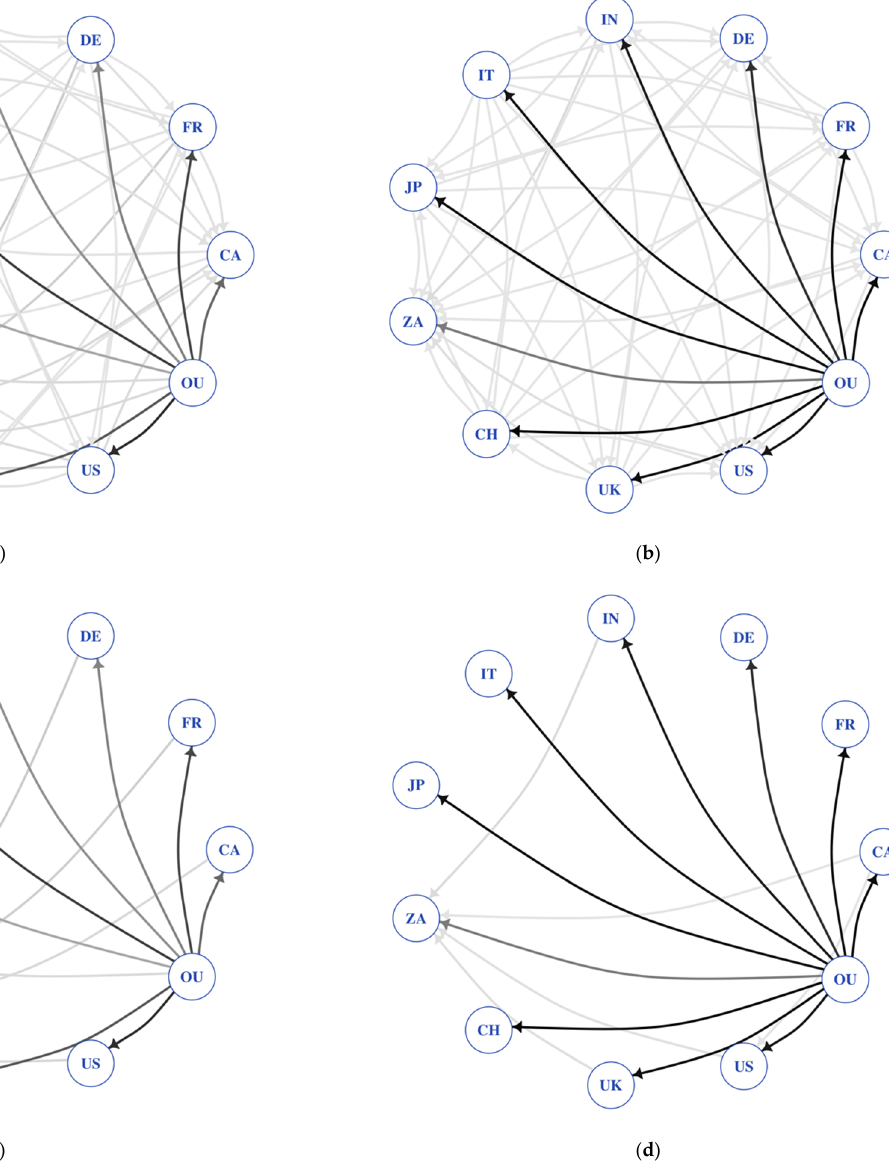
Figure 1. Connectedness based on the STVAR model. Net connectedness is based on the pairwise net spillovers obtained from the STVAR model estimates reported in Table 2. Thresholding sets values below the 75th percentile of the spillover to zero. Darker color intensity indicates stronger links. ( a ) Net connectedness without thresholding in the lower regime. ( b ) Net connectedness without thresholding in the upper regime. ( c ) Net connectedness with thresholding in the lower regime. ( d ) Net connectedness with thresholding in the upper regime.